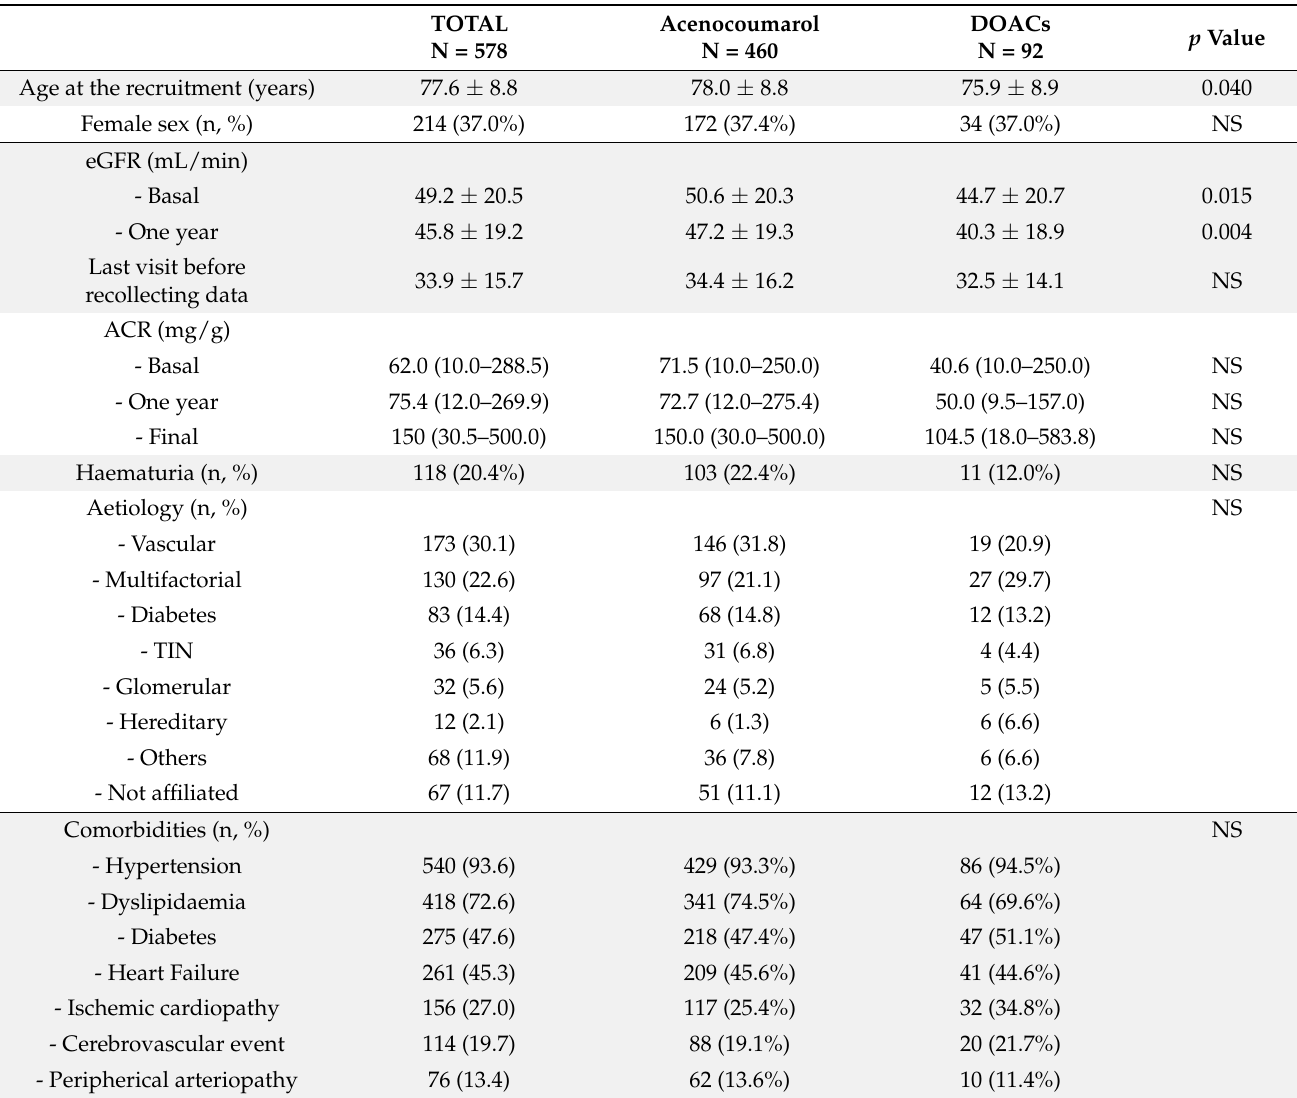
Table 1. Baseline characteristics of the patients